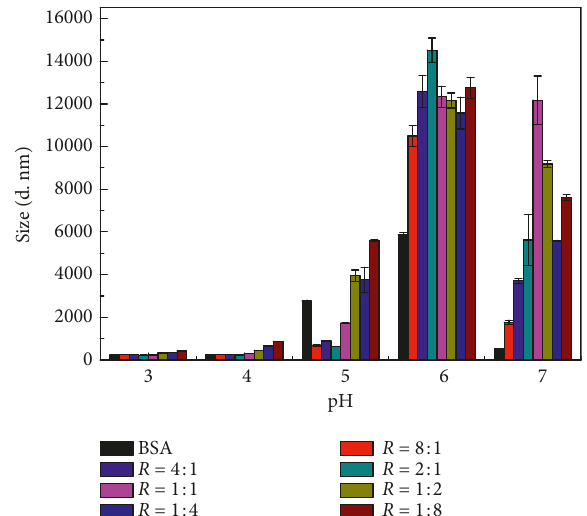
Figure 6: Particle size ( d , nm) of emulsions (5% v/v oil, pH 3.0–7.0) stabilized by BSA (0.15%, w/v) and BSA-WSC mixtures with different biopolymer ratios ( R � BSA :WSC) in acetate buffer (0.1 mol/L) at 25 °